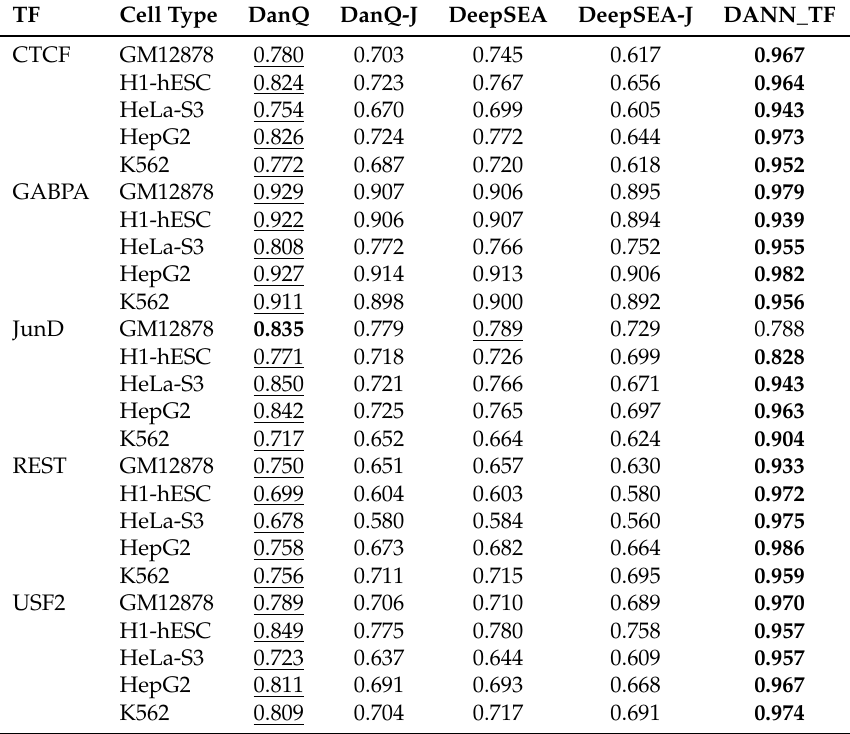
Table 4. AUCs of our proposed method and the four state-of-the-art methods. (The best performers and the second-best performers are marked by bold and underline,